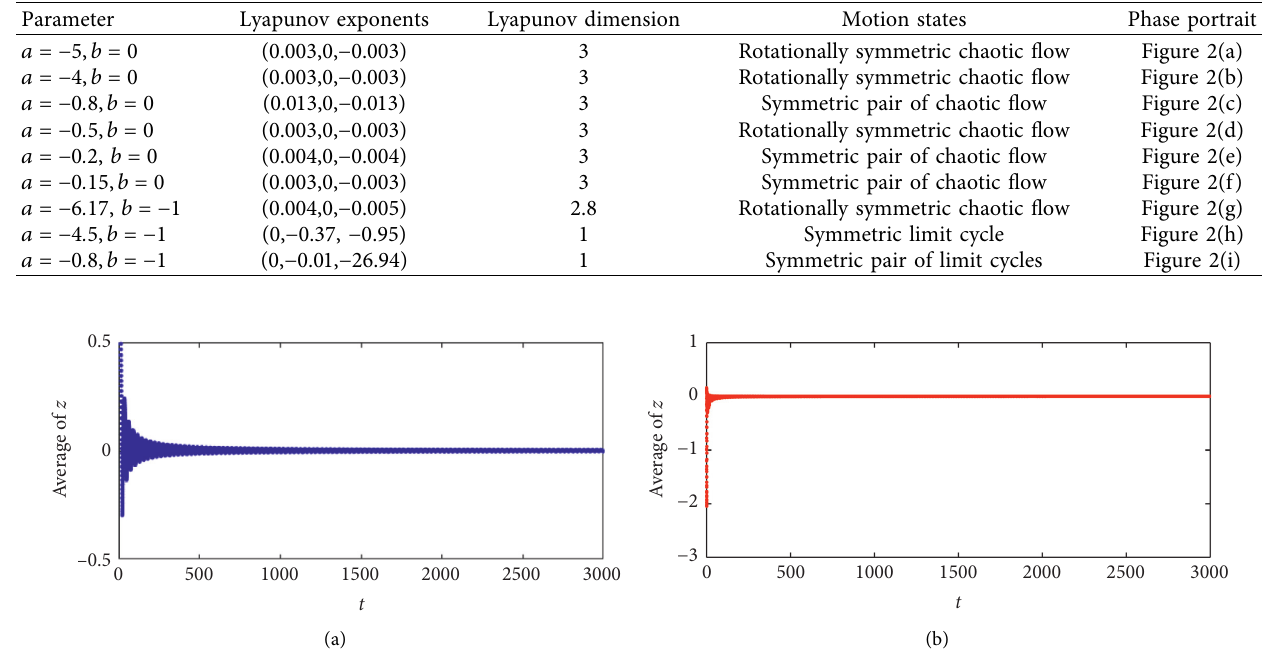
Figure 1: Time-averaged value of z ( t ) for system (1) with different parameters a, b,c . (a) a � 0.2, b � 0, c � 1. (b) a � − 4, b � 0, c �